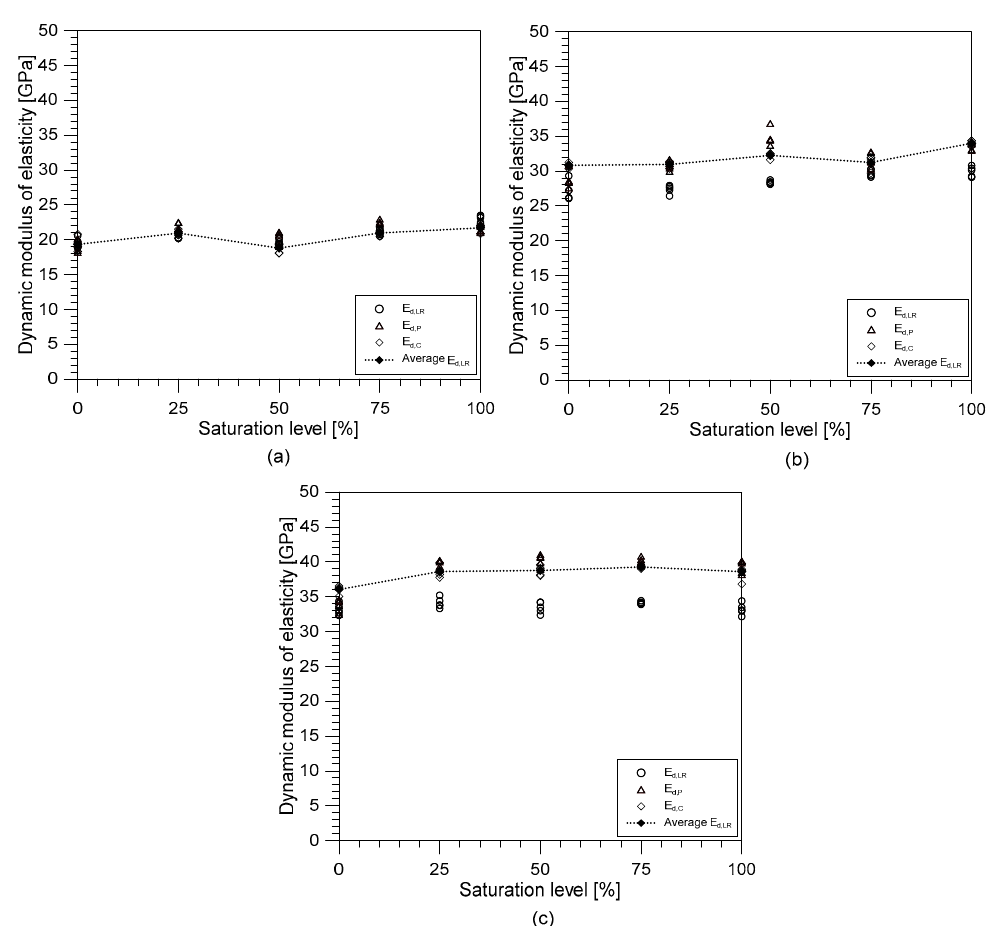
Figure 12. Variation of dynamic elastic modulus of concrete with increasing saturation level for: ( a ) MIX 1, ( b ) MIX 2, and ( c ) MIX 3. Note that the dynamic elastic moduli, E d,P and E d,S , were calculated with a Poisson’s ratio from Section 3.2.